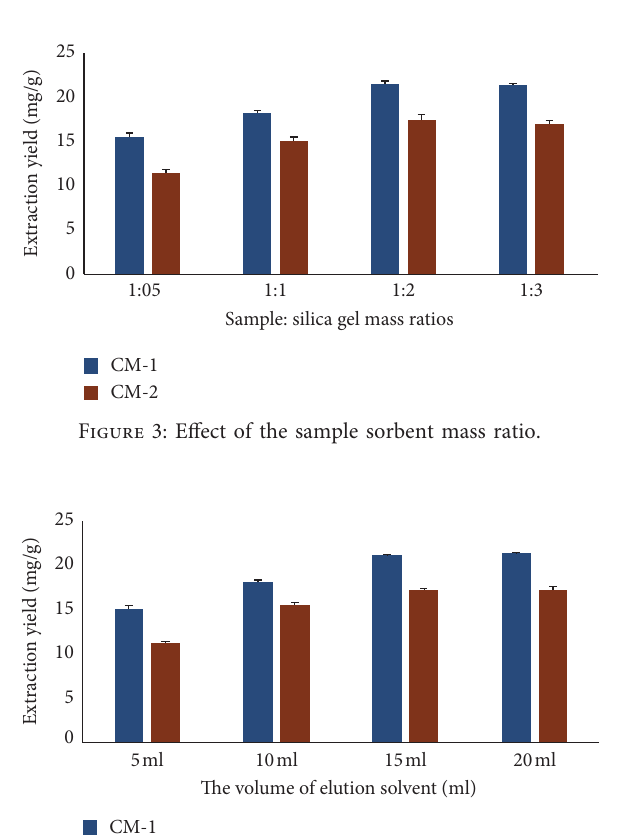
Figure 2: Effect of the dispersing sorbents on extraction yields.